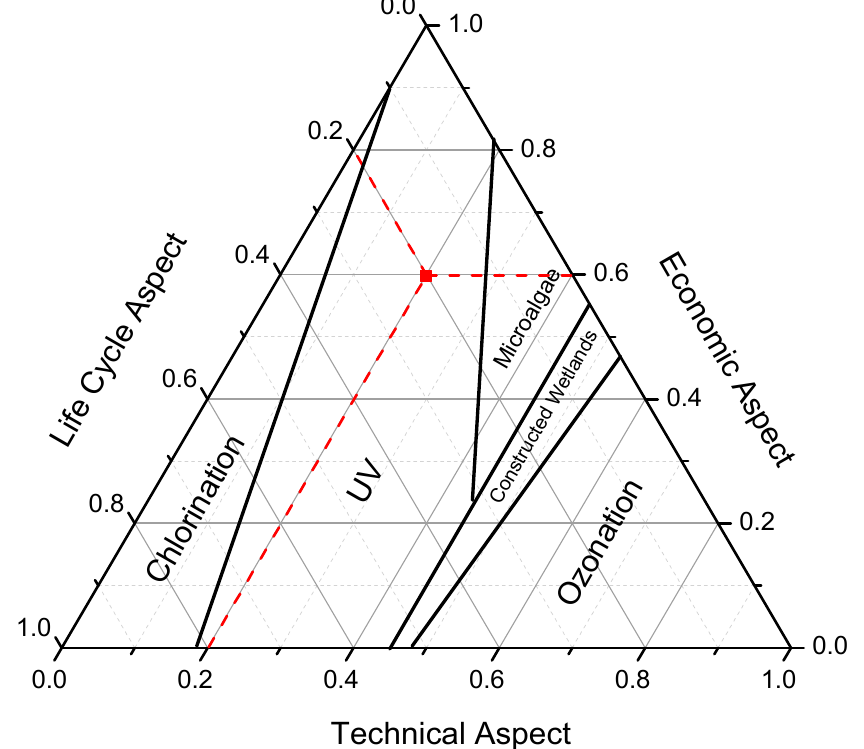
Figure 2. Ternary diagram for the evaluation of tertiary treatment methods, with an example of 0.2, 0.6, and 0.2 weights for the technical, economic, and life cycle aspects, respectively.